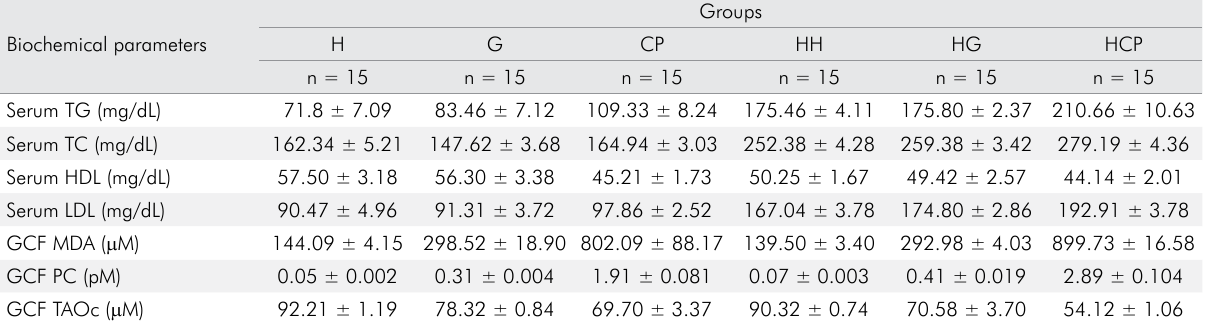
Table 2. Serum lipid levels of subjects and GCF MDA, PC, and TAOC levels as total amount of sampling sites in the study groups. Biochemical parameters